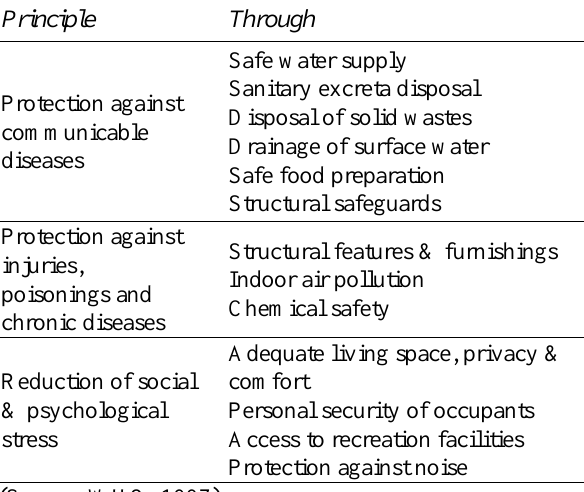
Table 1: Principles of healthy